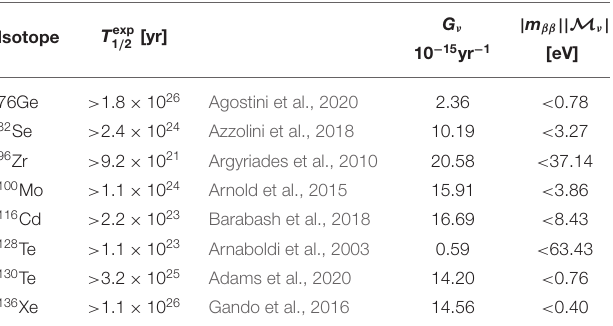
TABLE 6 | Upper limits on | m ββ || M ν | from current experimental bounds T exp 1 / 2 at 90% CL and taking g A =